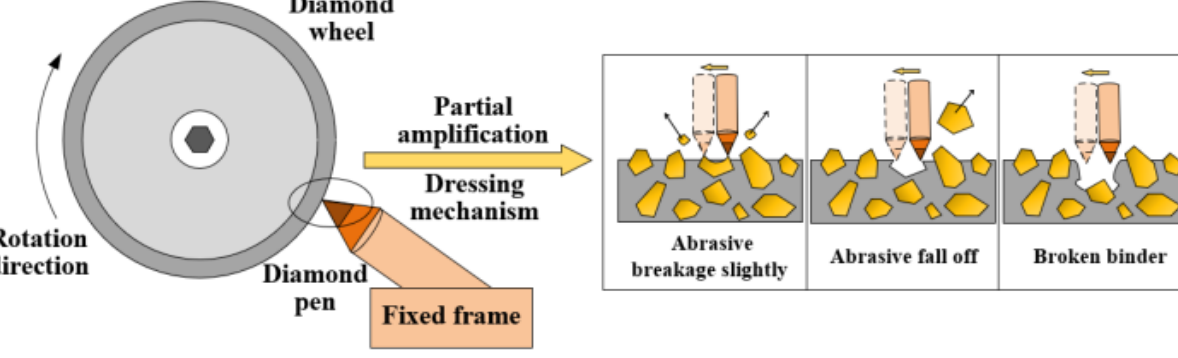
Figure 2. Schematic diagram of diamond pen dressing diamond abrasive grinding wheel.